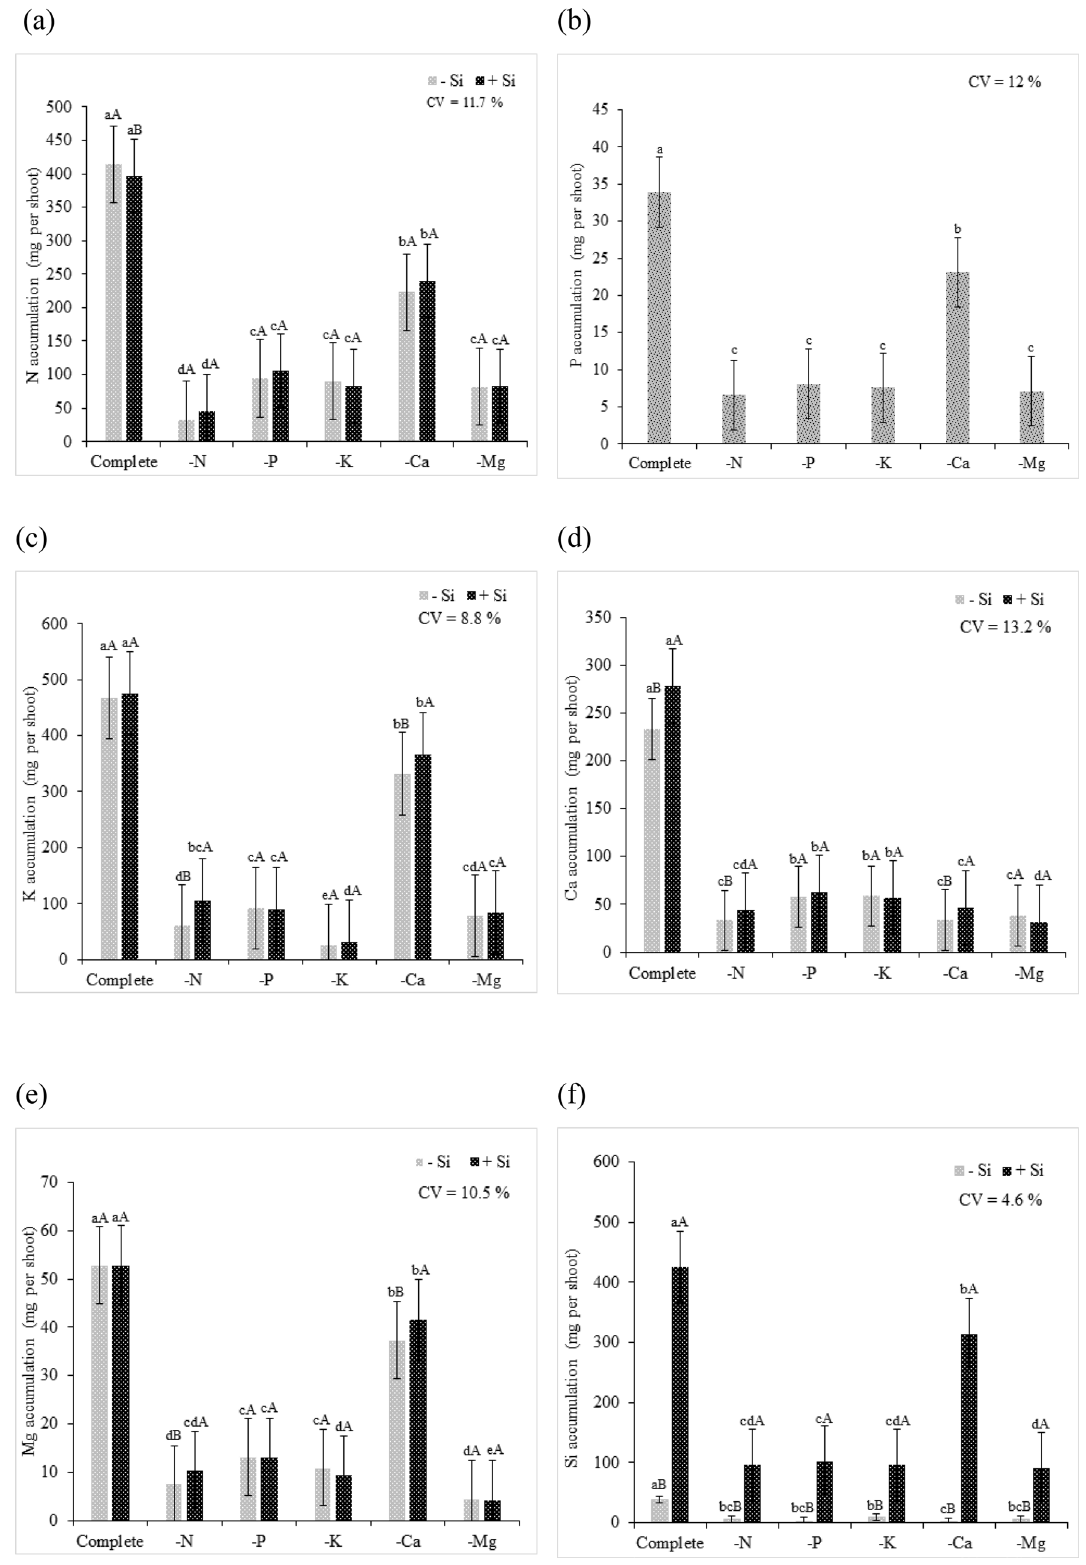
Figure 4. Nutrient accumulation in quinoa plants in a Hoagland solution (Hoagland and Arnon 23 ) under omission of macronutrients in the absence (− Si) and presence of silicon (+ Si), ( a ) N accumulation (mg per plant), ( b ) P accumulation (mg per plant), ( c ) K accumulation (mg per plant), ( d ) Ca accumulation (mg per plant), ( e ) Mg accumulation (mg per plant), and ( f ) Si accumulation. Equal lowercase letters show a similarity between omission and complete treatments by Tukey’s test at 5% probability. Equal uppercase letters show a similarity between treatments (− Si and + Si) by Tukey’s test at 5% probability. Software used to create this Figure was Microsoft Excel (v1804, https:// www. micro soft.